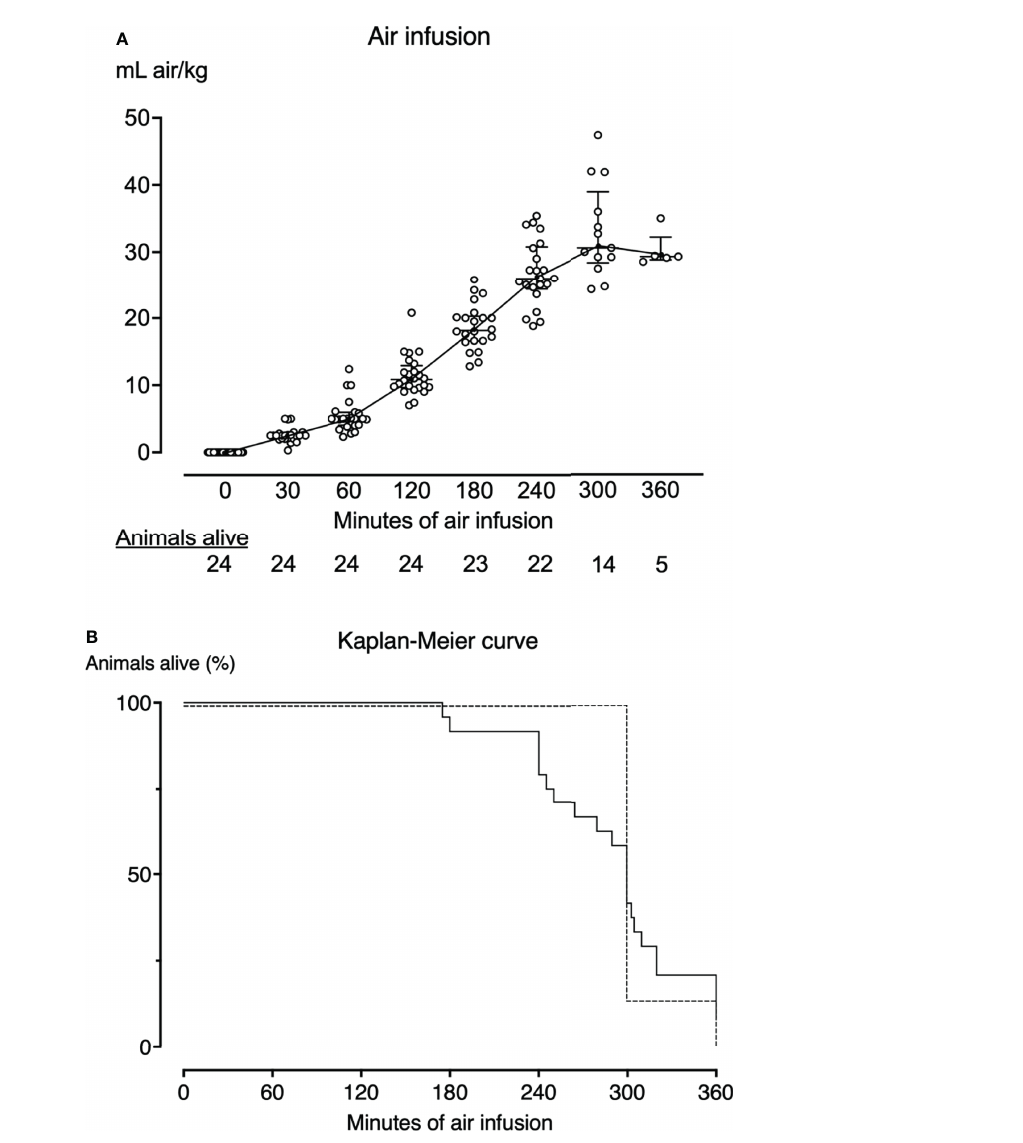
FIGURE 2 | Air infusion protocol and survival curves. (A) Twenty-four pigs received intravenous air infusion based on body weight. The infusion rate was increased hourly. Each point represents one pig. The horizontal lines indicate the median infusion rate. Error bars span the interquartile range. Animals are only included in the graph until death. Pigs alive at each sample point are listed below the graph. (B) Kaplan-Meier survival curve of the animals that received air infusion (solid line) and sham animals (dotted line). Pigs that received air infusions died after a median of 300 minutes (IQR 249-320). All sham animals lived until the end of the observation period of either 300 (n=6) or 360 minutes